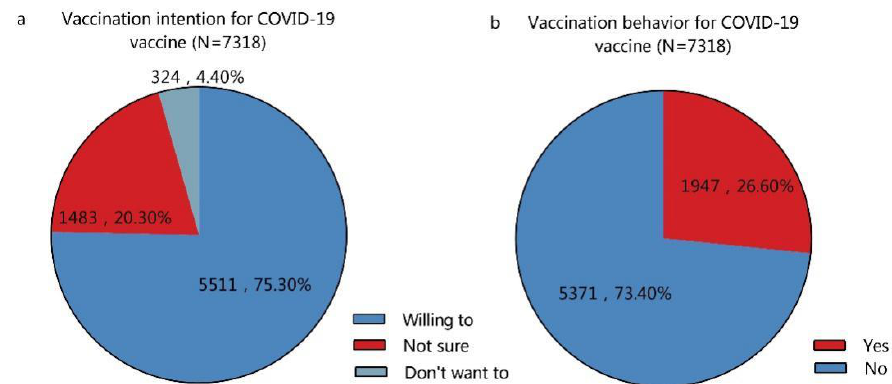
Figure 3. Participants declaring COVID-19 vaccination ( a ) intention and ( b ) uptake.